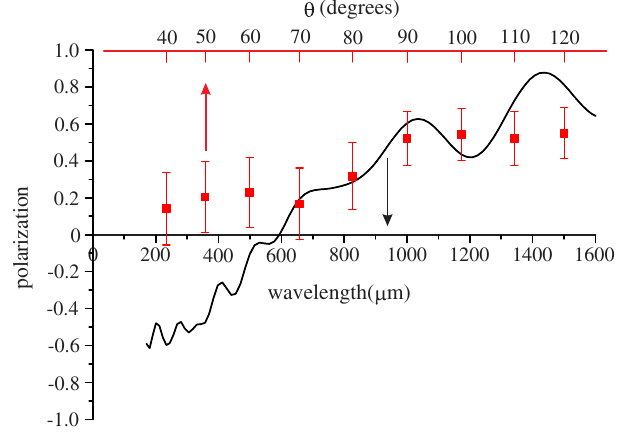
FIG. 6. The measured degree of polarization of the grating signal as a function of observation angle. The solid line is the theoretically predicted polarization of cSPr from the 1.0 mm grating, as a function of